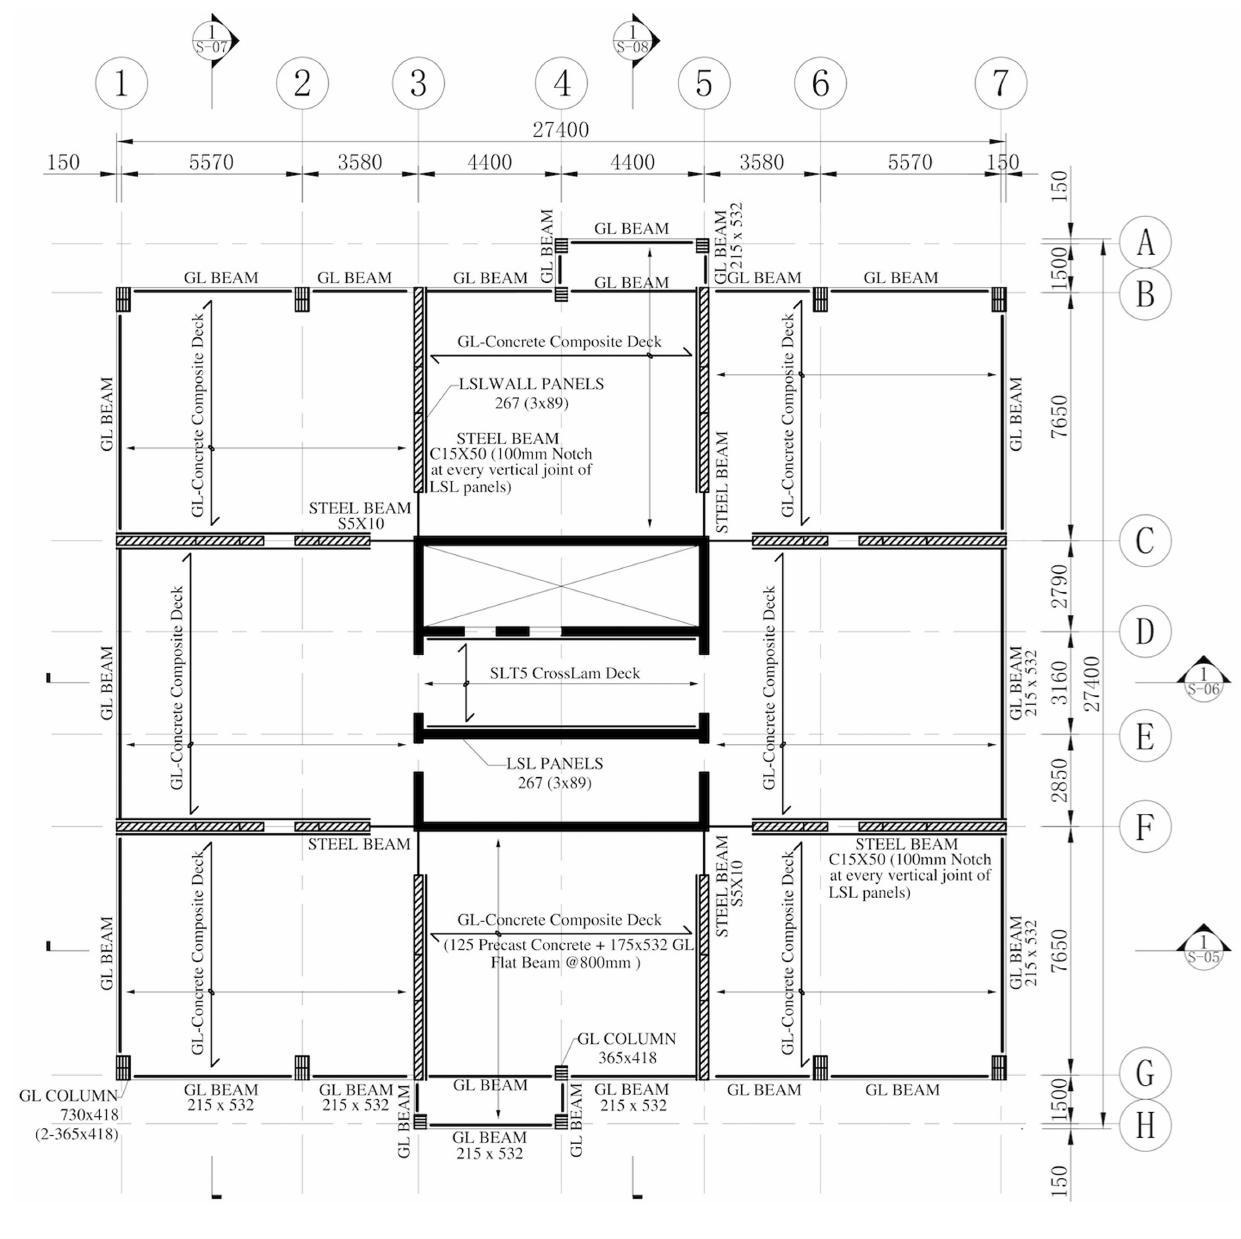
FigUre 2 | Typical structural member details of the CHECKER